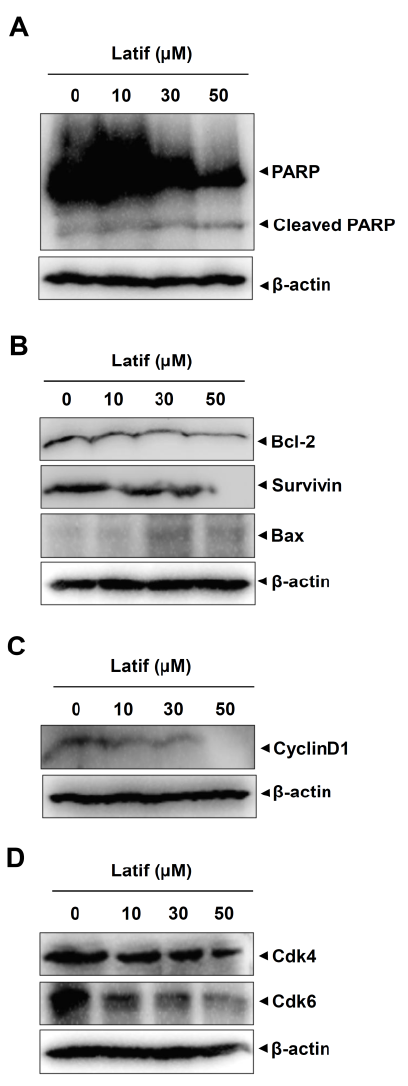
Figure 3. Effects of Latif on apoptosis- and cell cycle-related proteins in human YD-10B OSCCs. ( A – D ) Amounts of 10, 30, and 50 μ M Latif was treated for 24 h in YD-10B OSCCs, equal amounts of proteins were obtained from total cell lysates, and then PARP, cleaved PARP ( A ), Bcl-2, Survivin, Bax ( B ), CyclinD1 ( C ), Cdk4, and Cdk6 ( D ) were analyzed using Western blot analysis. β -actin level was detected as a loading control. Data are representative of the results of three experiments.